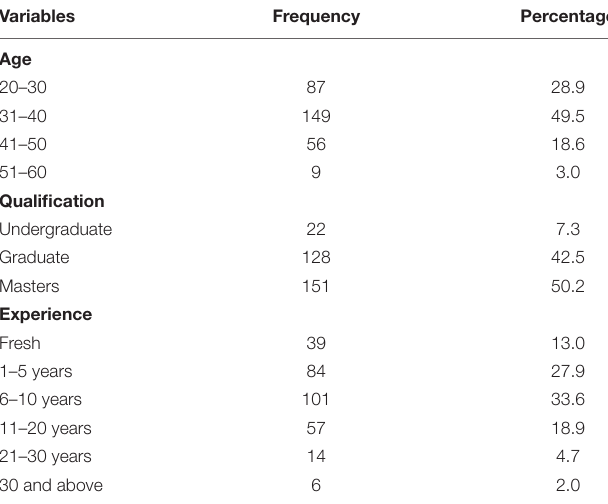
TABLE 1 | Demographic